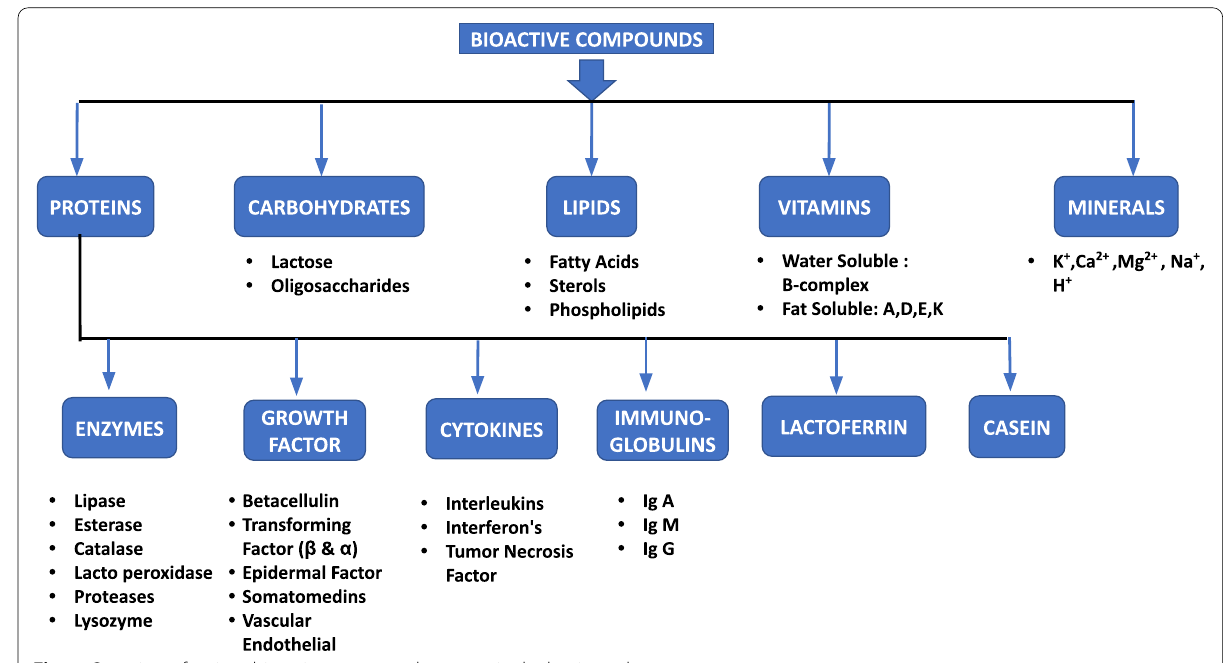
Fig. 1 Overview of various bioactive compounds present in the bovine